Question: What kind of plot is shown here?
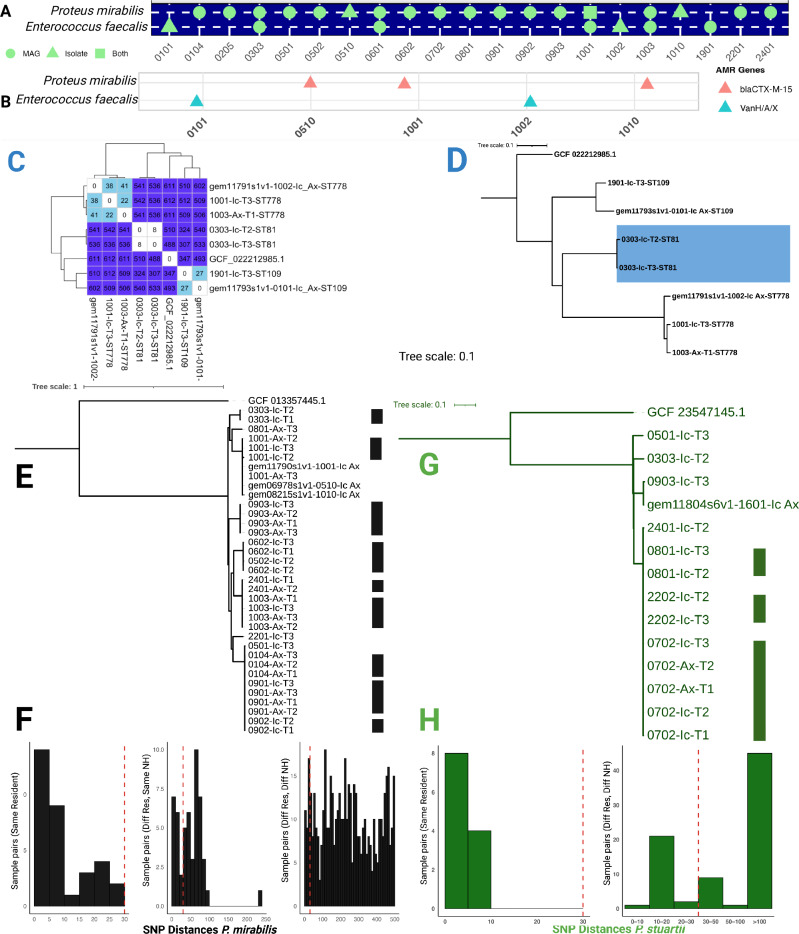
Answer: heatmap